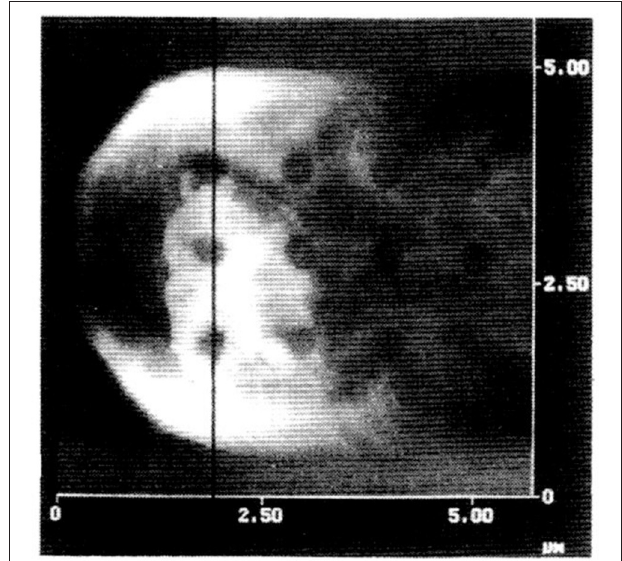
FIGURE 4 | MOSFET second breakdown in cascoded NFETs in a 0.35 µ m technology (with permission from the ESD Association).